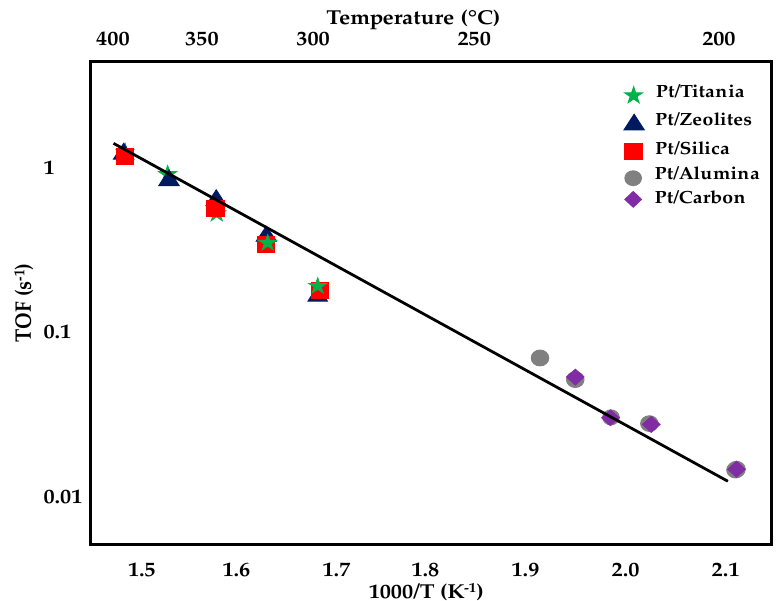
Figure 15. TOF of the WGS reaction on Na-containing Pt catalysts on various supports, adapted from [92], with permission from Elsevier, 2017; 11% CO, 26% H 2 O, 7% CO 2 , 26% H 2 , 30% He. Zhu et al. [94] investigated the effect of sodium addition on the WGS activity of 1 wt%Pt/TiO 2 catalysts; the kinetic measurements were performed between 250 and 300 °C under a stream of 2.83% CO, 5.66% H 2 O, 37.74% H 2 and 53.77% He. Na incorporation slightly increased the apparent